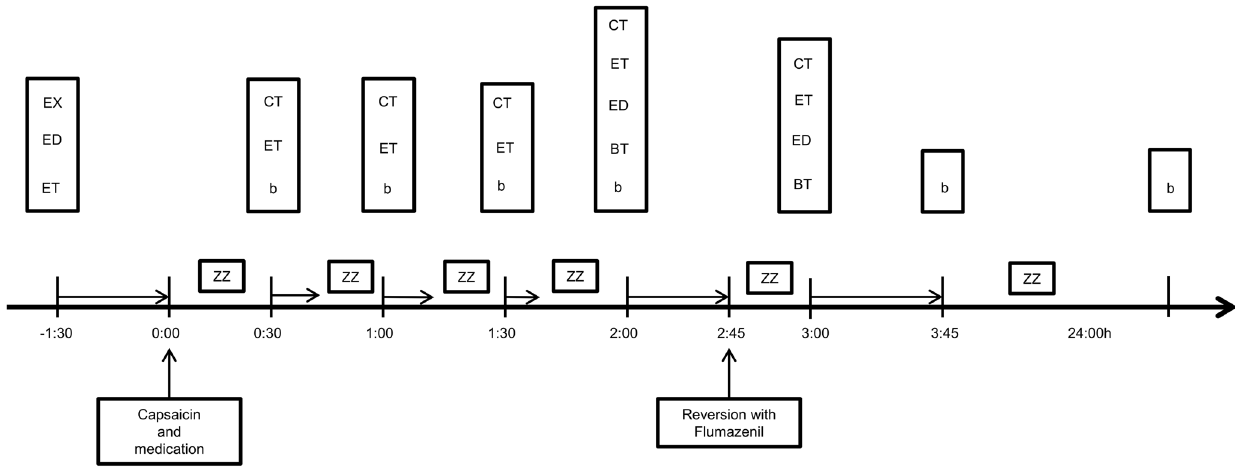
Figure 3. Time plan of the experiment. Horizontal arrow: Testing time; ZZ: Resting time; EX: Medical examination, installation of the testing equipment and training measures; CT: Measures on the area of capsaicin hyperalgesia; ET: Cutaneous electrical stimulation; ED: Intramuscular electrical stimulation, pressure stimulation, cold pressor test, conditioned pain modulation and cuff algometry; BT: Psychomotor performance test; b: Blood sample.